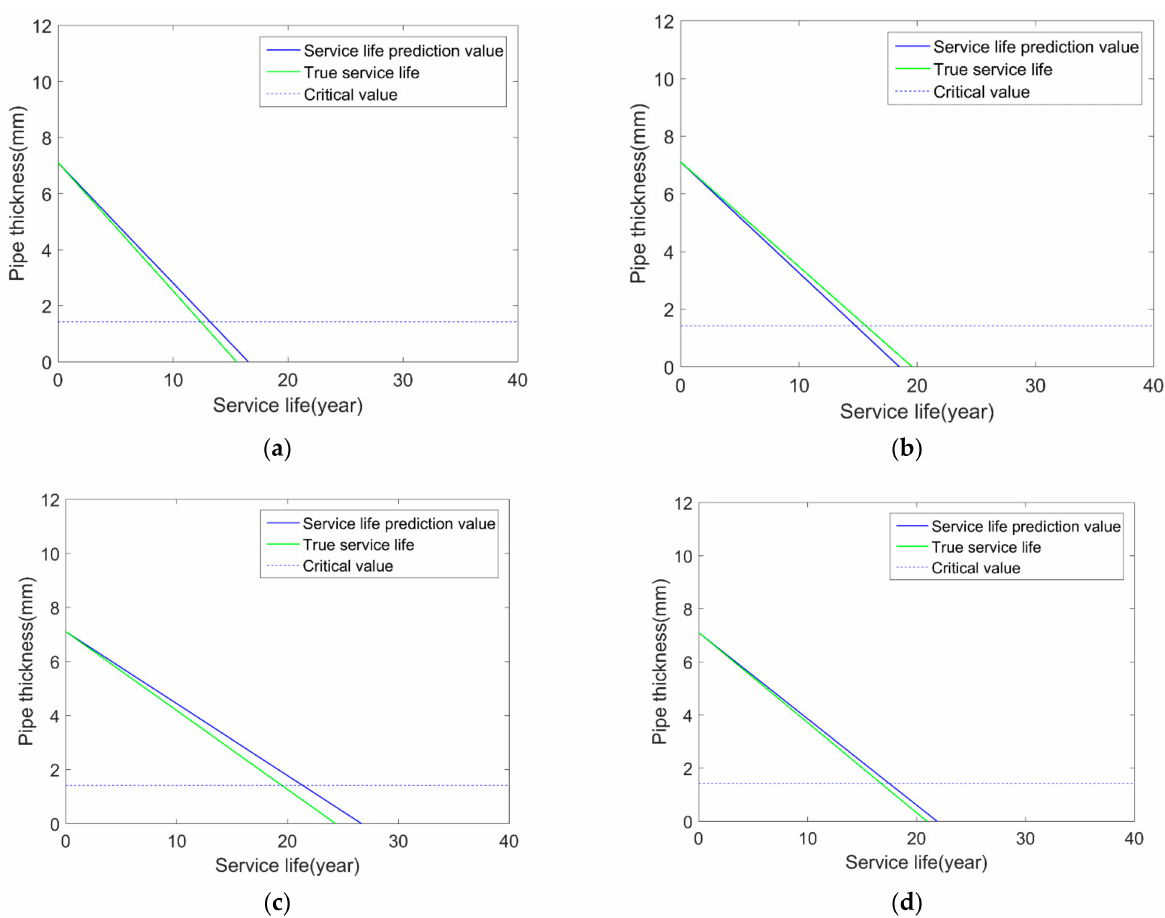
Figure 2. Comparison results of pipeline life prediction: ( a ) sample 1; ( b ) sample 2; ( c ) sample 3; ( d ) sample